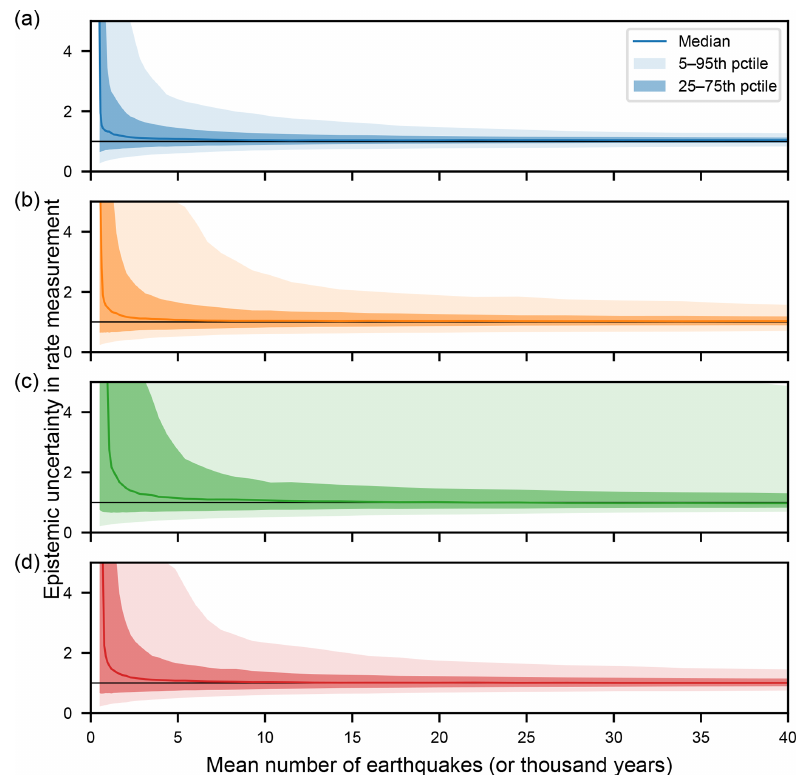
Figure 6. Epistemic uncertainty relative to the measured rate for each of the recurrence distributions as a function of the mean number of earthquakes (or thousands of years) over which the slip rates were measured. (a) periodic distribution; (b) unclustered lognormal distribu- tion; (c) clustered lognormal distribution; (d) unclustered exponential